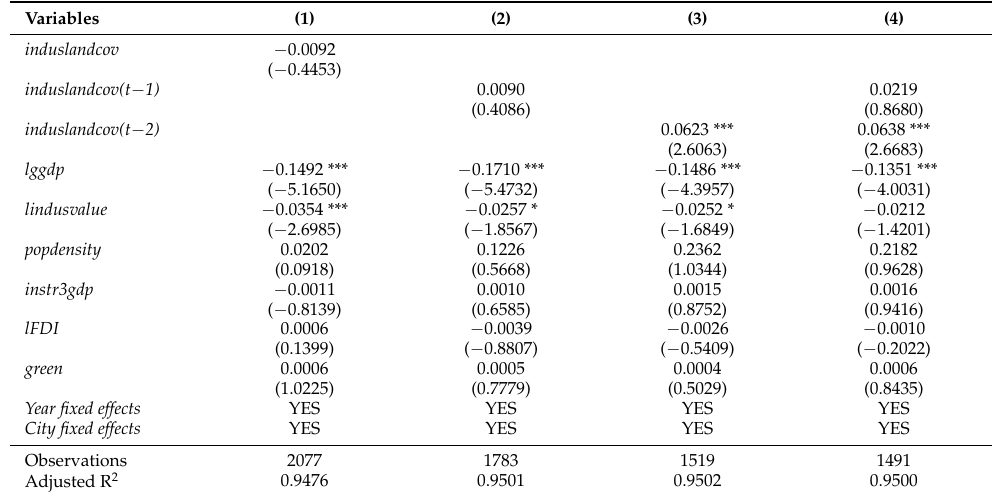
Table 3. Benchmark regression results.